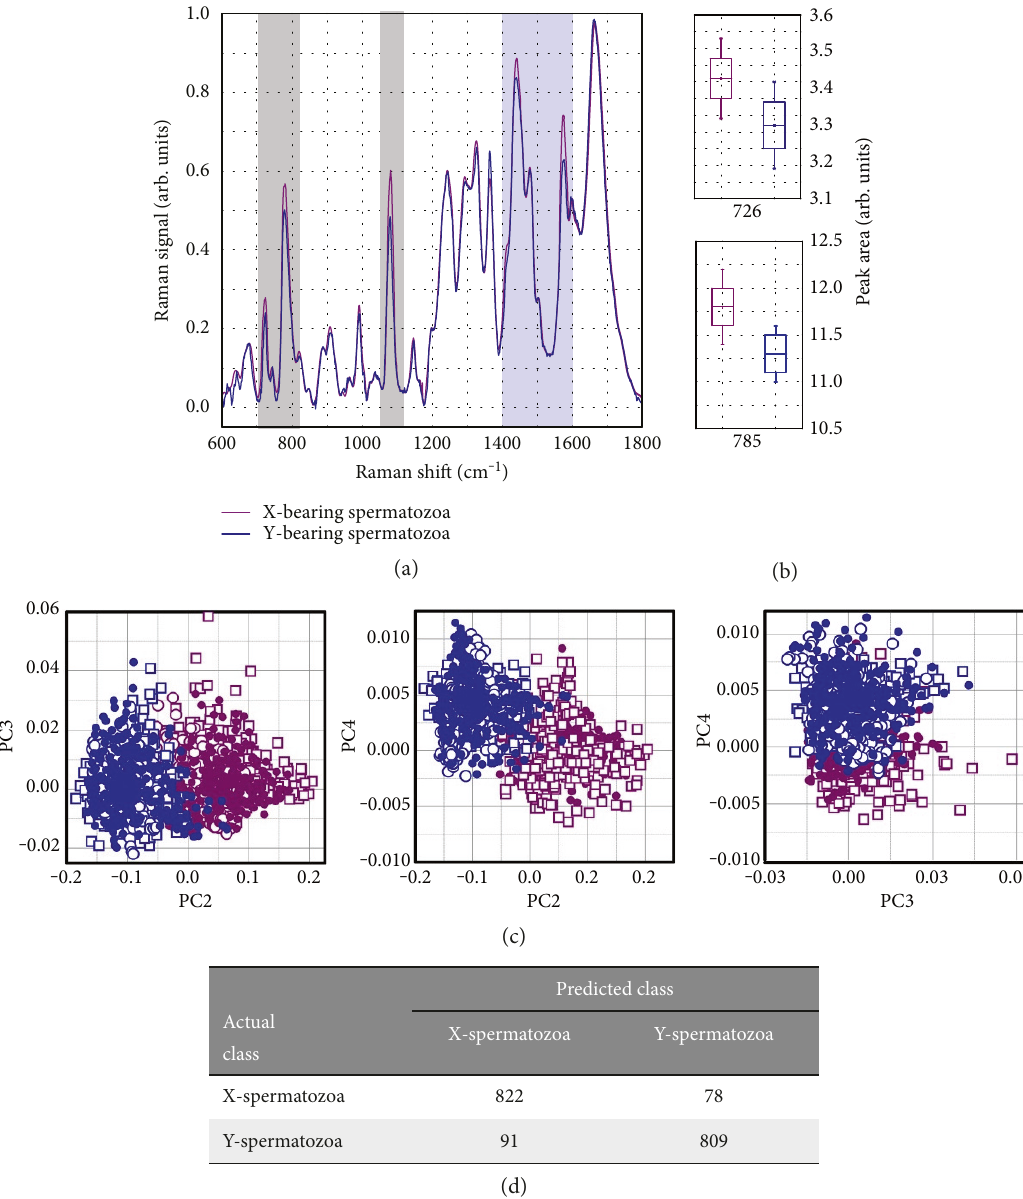
Figure 7: (a) Average Raman spectra of 900 X- (purple line) and 900 Y- (blue line) sperm cell spectra acquired in the “ fi ngerprint ” spectral region. The experiment has been performed on three di ff erent bulls. (b) Measured peak area of the bands at 726 and 785cm − 1 , highlighting the di ff erent DNA contents measured for X- and Y-sperm cells; Δ A = 4 2 ± 0 9% . (c) PCA score plots of PC2, PC3, and PC4 showing the separation of data corresponding to X- and Y-sperm cells. [6]. (d) Confusion matrix summarizing the correct and incorrect classi fi cations for the analysed X- and Y-sperm spectra [6, 63,